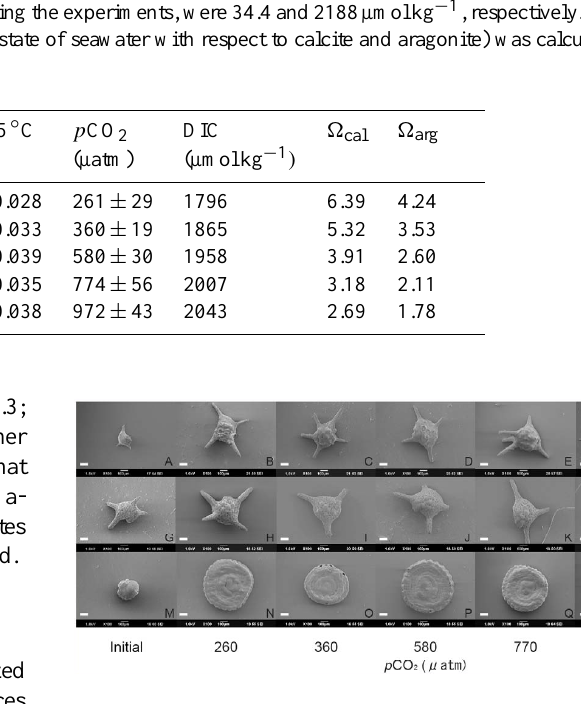
Fig. 2. SEM images of cultured individuals at various p CO 2 lev- els (scale bar = 100µm). Photographs are shown for average-sized specimens from the population α of each species. (A to F) Bac- ulogypsina sphaerulata , (G to L) Calcarina gaudichaudii , (M to R) Amphisorus hemprichii . (A, G, M) initial individuals, (B, H, N) specimens subjected to 260µatm, (C, I, O) specimens subjected to 360µatm, (D, J, P) specimens subjected to 580µatm, (E, K, Q) specimens subjected to 770µatm, (F, L, R) specimens subjected to